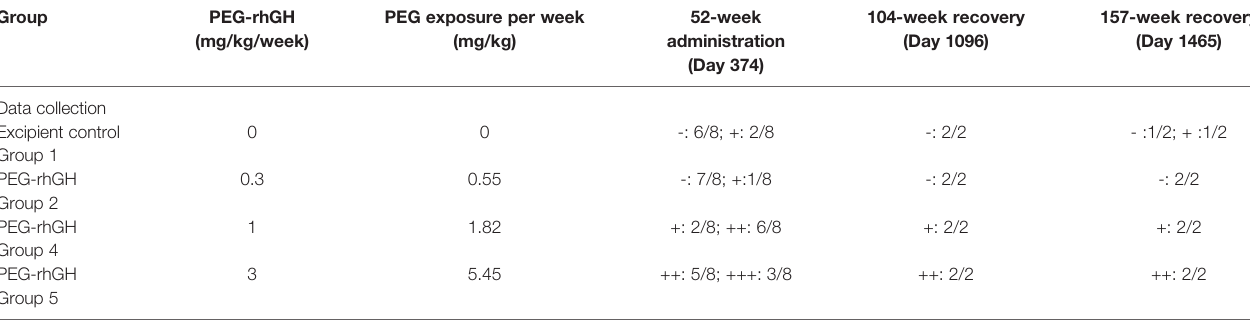
TABLE 3 | H&E staining counts of CP epithelium with 52-week administration at dose of 0.3, 1 and 3 mg/kg/week and after 104-/157- week recovery.